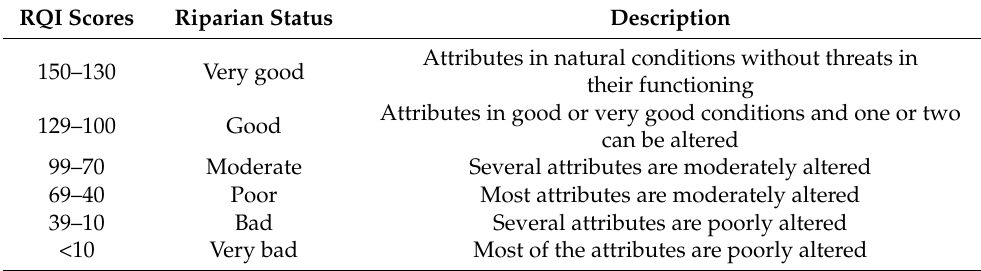
Table 3. Riparian Status according to